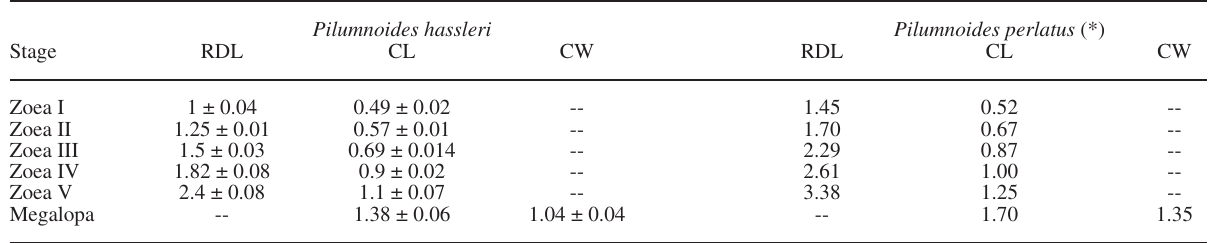
Table 1. – measurements (in mm) of each larval stage of Pilumnoides hassleri and P. perlatus. rdL , rostrodorsal length; CL, carapace length (mean ± sd); CW, carapace width. Pilumnoides hassleri